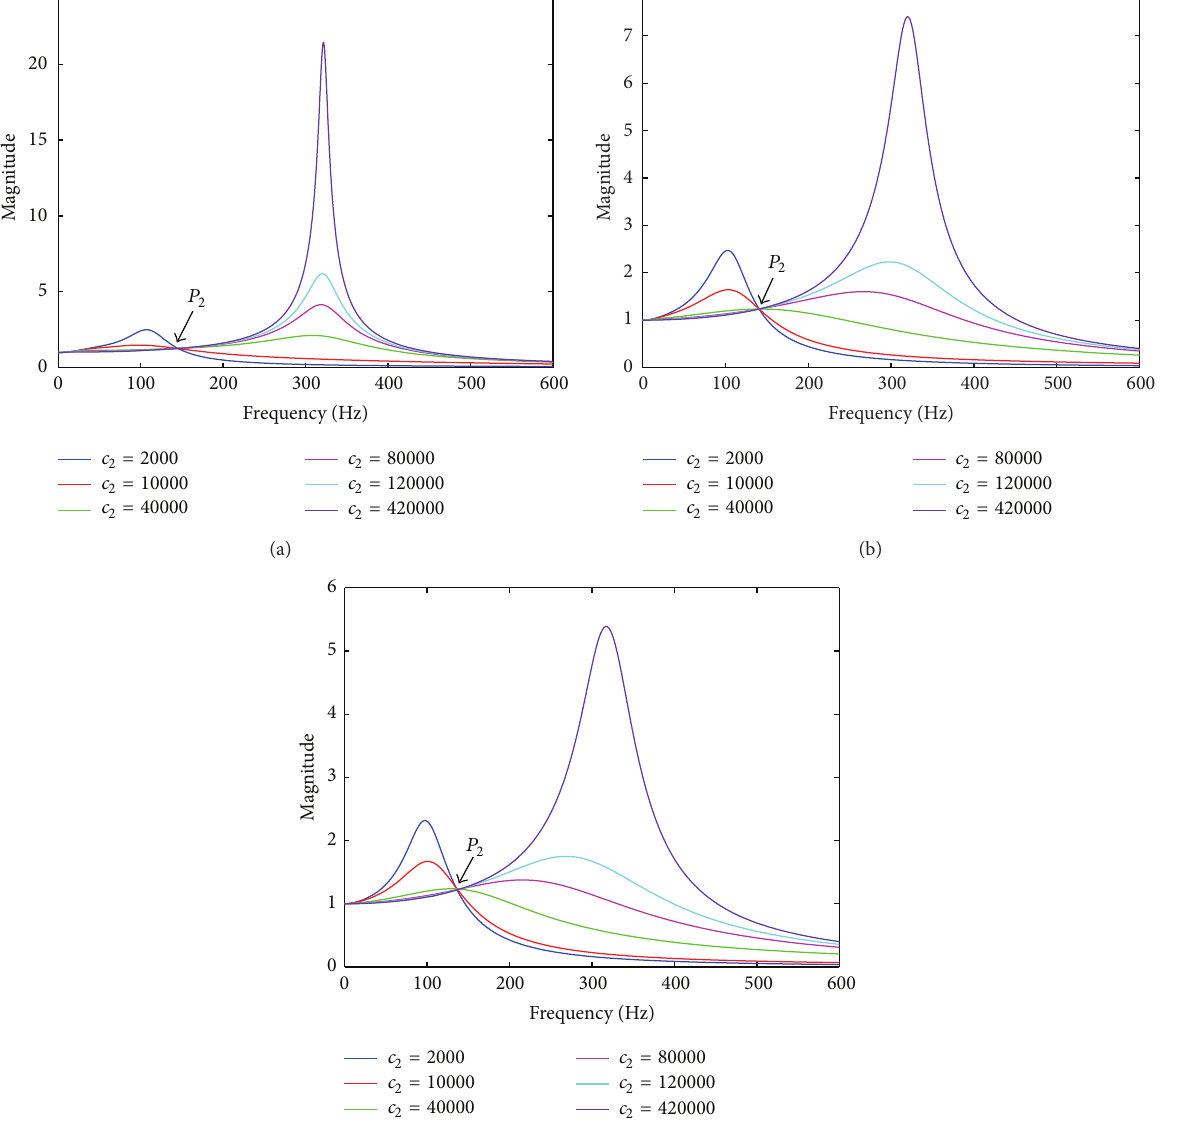
to those of the GNM in Section 4.1 and will not be repeated